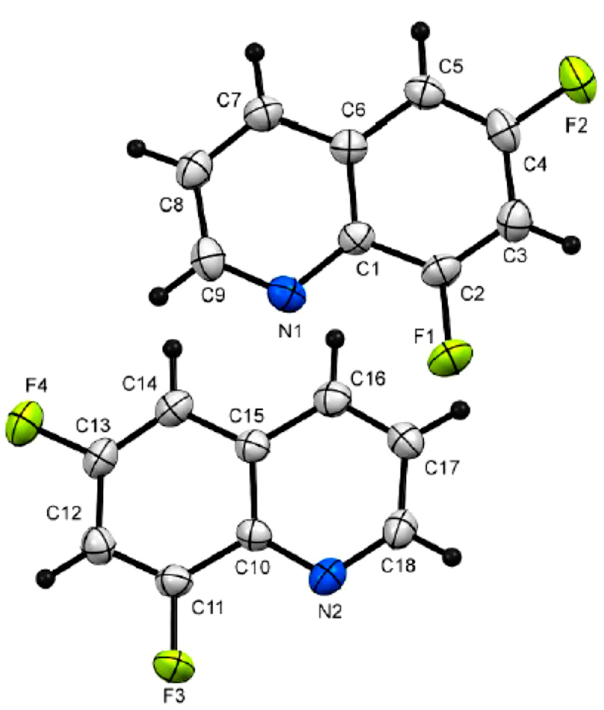
Figure 1. X-ray crystal structure of 6,8-difluoroquinoline 6b .